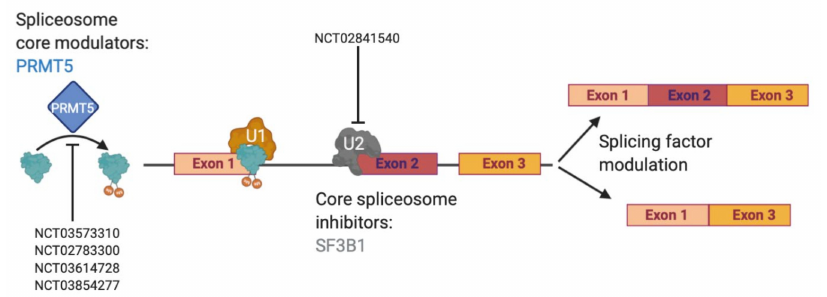
Figure 2. Splicing can be modulated at multiple levels. Pre-splicing, modifying enzymes, like the methyltransferase PRMT5, can be inhibited preventing spliceosome assembly. Core spliceosome components, like SF3B1, can also be inhibited leading to unproductive splicing. Isoform modulation can also be a target of alternative splicing to switch to a less oncogenic protein isoform. Clinicaltrials. gov identifiers (NCT) are included where small molecule inhibitors or modulators are being tested in